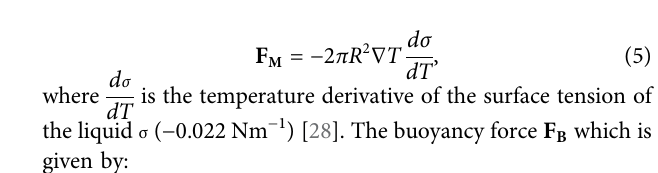
Frontiers in Physics |